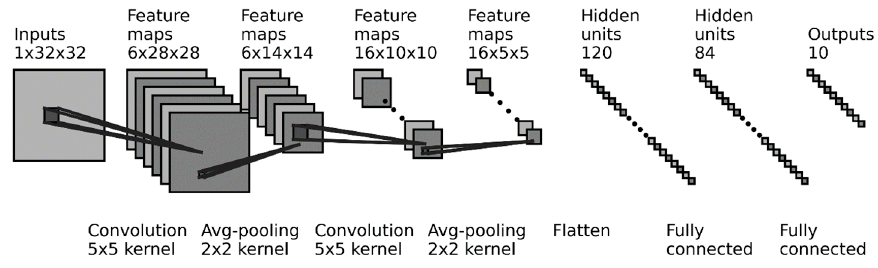
Figure 1. Architecture of LeNet-5.